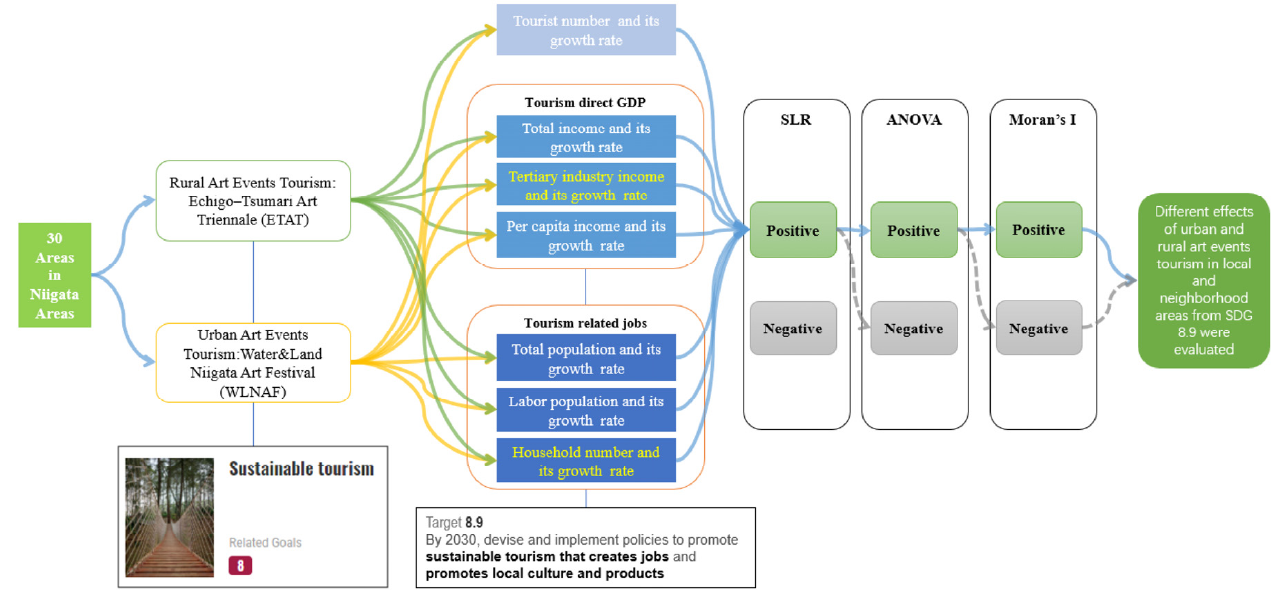
Figure 1. The structure. ANOVA = analysis of variance; SLR = simple linear regression; SDGs = sustainable development